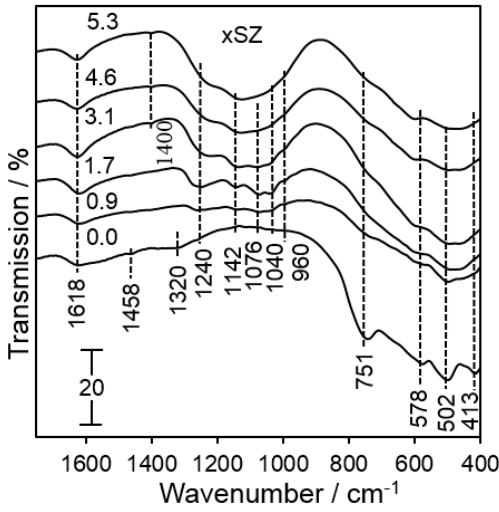
Figure 5. Ex situ FTIR transmission spectra for 550 °C calcined parent and sulfated zirconia as a function of bulk S loading.